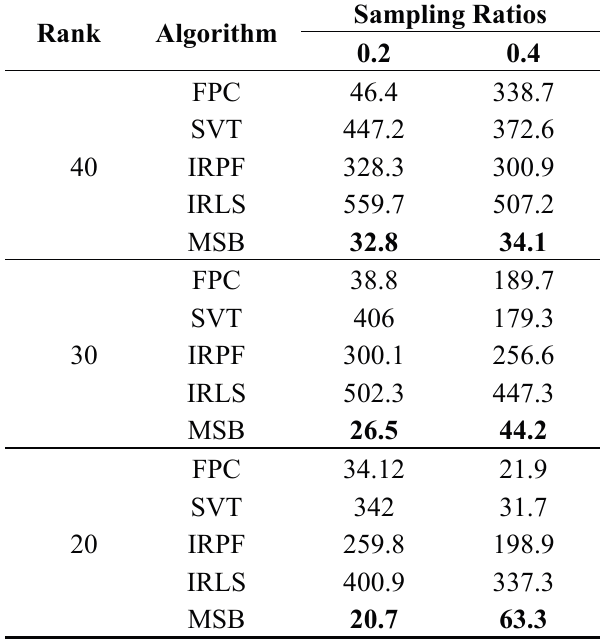
Table 1. Run times for different